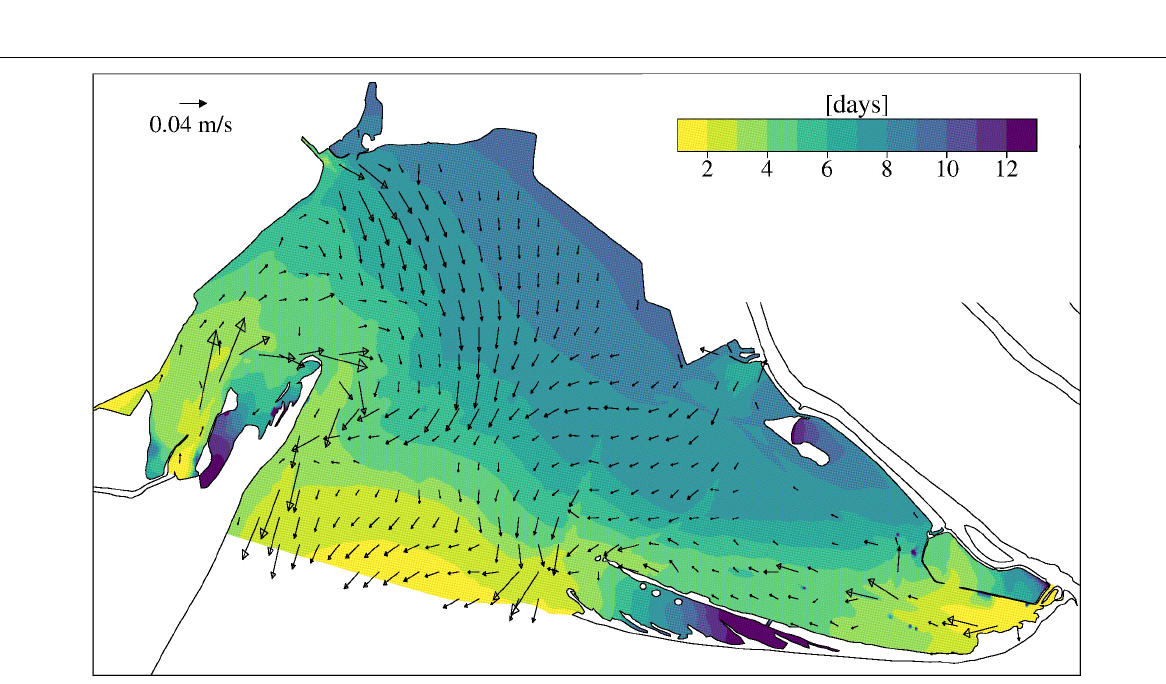
FIGURE 6 | (A) mean sea level and (C) surface salinity field during an intense Bora wind event, occurred the February 22–26, 2018. (B) Means sea level and (D) surface salinity field during an intense Sirocco wind event, occurred the October 27–31, 2018.